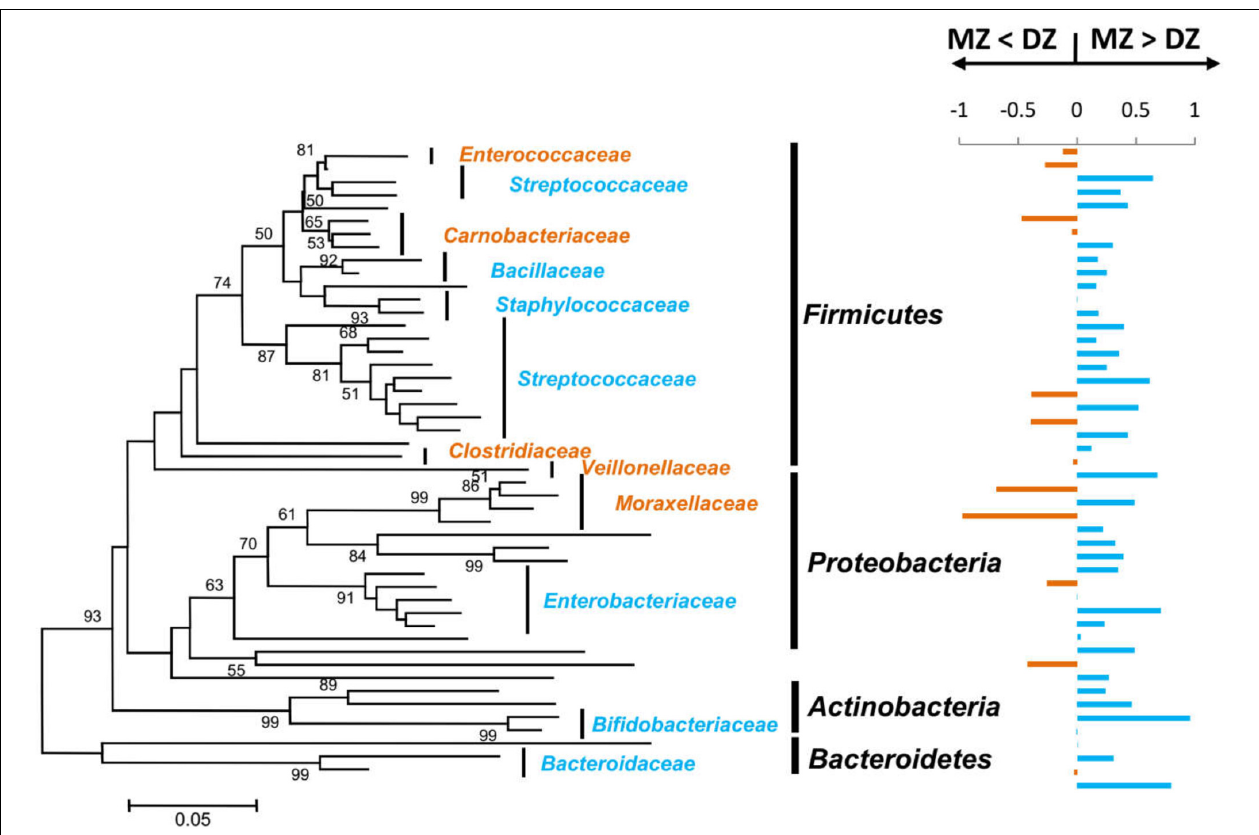
FIGURE 5 | Operational taxonomic units relative abundances correlated within MZ and DZ twin pairs. On the left is a neighbor-joining phylogenetic tree of OTU shared by > 50% of the samples in this study. Major bacterial families that the OTUs were classified into were labeled. Bootstrap values > 50% were shown and the bar shows 5% difference in the nucleotide sequence. On the right are corresponding twin-pair intraclass correlation coefficients (ICCs). For each of the OTUs, ICCs were calculated and compared between DZ and MZ. Bars that point to the right represent that the difference is positive (i.e., MZ ICCs > DZ ICCs), colored in blue, and bars that point to the left represent negative differences (i.e., DZ ICCs > MZ ICCs), colored in orange. The families were colored in accordance with the bars.